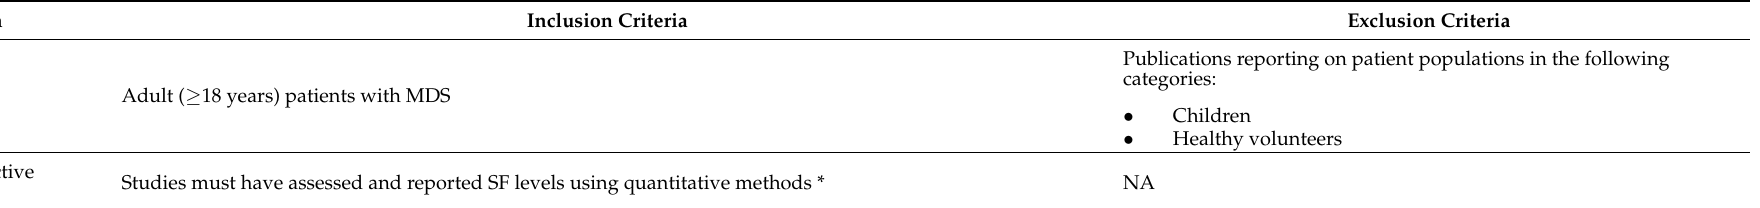
Table 1. Screening/eligibility criteria for myelodysplastic syndromes